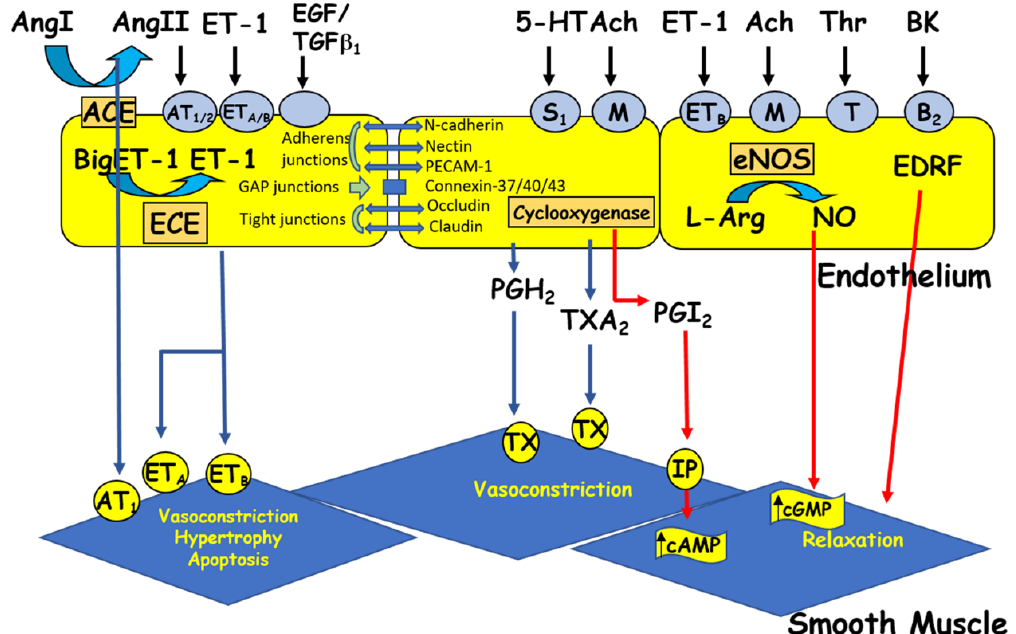
Figure 2. The endothelium produces vasoactive factors that cause either relaxation or contraction of the vascular smooth muscle. Ang I and II: angiotensin I and II, ACE: angiotensin-converting